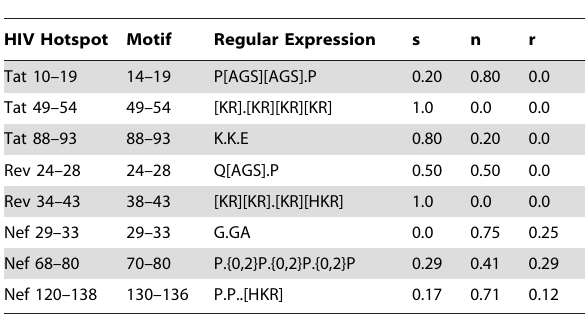
Table 5. Surface accessibility composition (hydrophilic, neutral, and hydrophobic) of motifs in HIV protein hotspots along the collections of viral protein